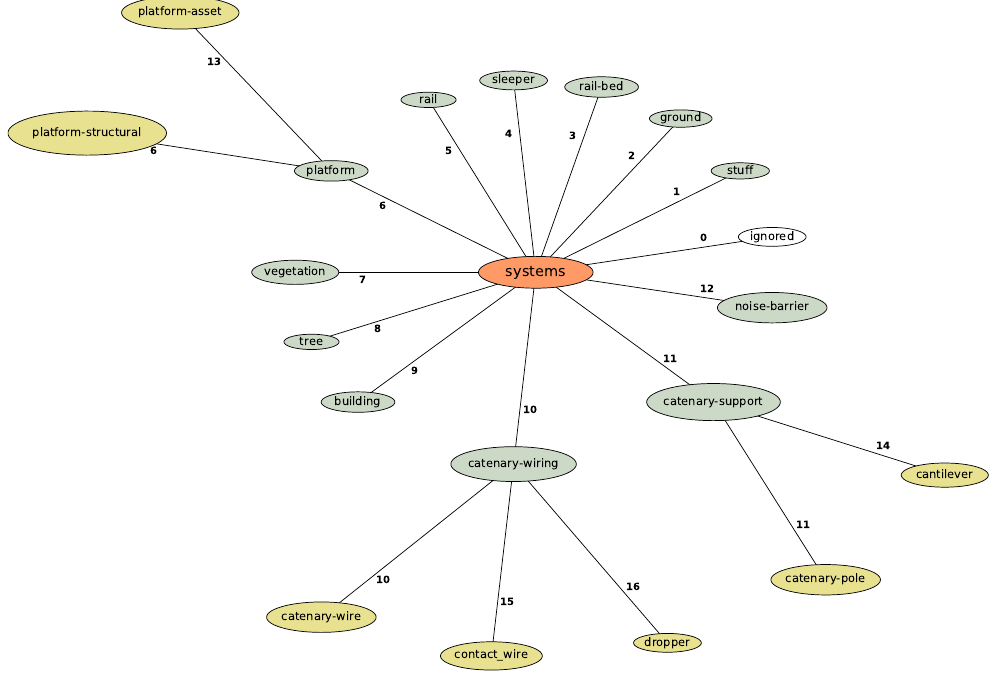
Figure 4. Overview of the experiment-specific objectification. The 12-system hierarchy is represented in green; the breakdown of the extended 16 systems is represented in